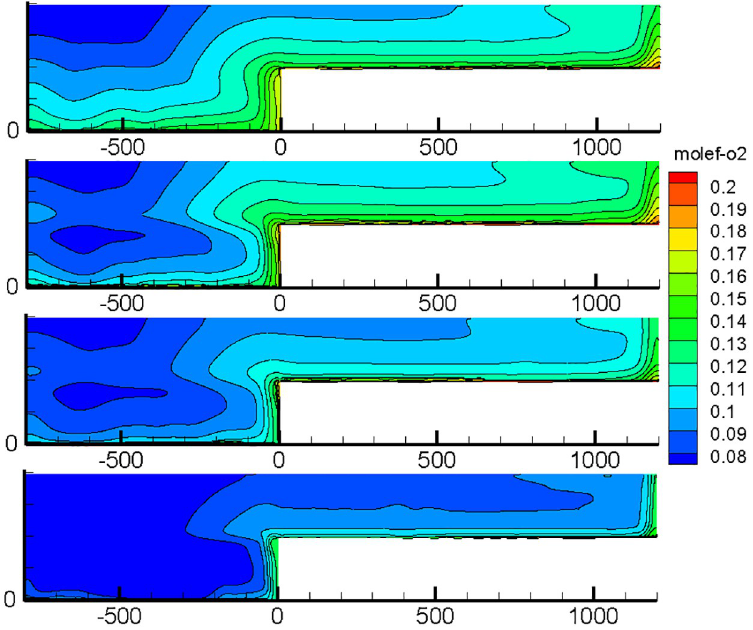
Fig 14. Distribution results of the oxygen flow field in the goaf with different nitrogen injection rates.